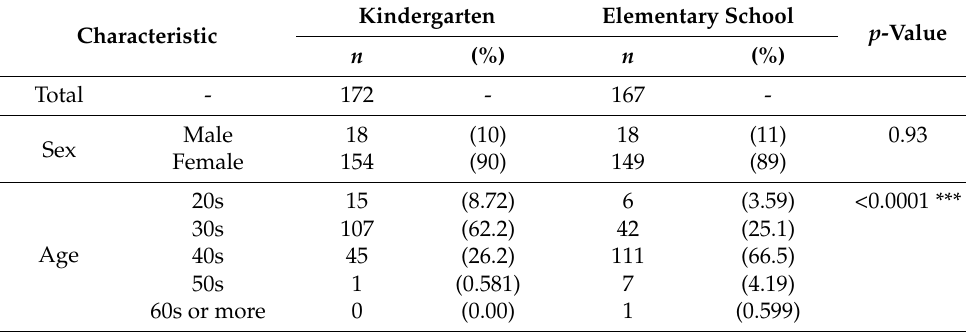
Table 1. Characteristics of participants.